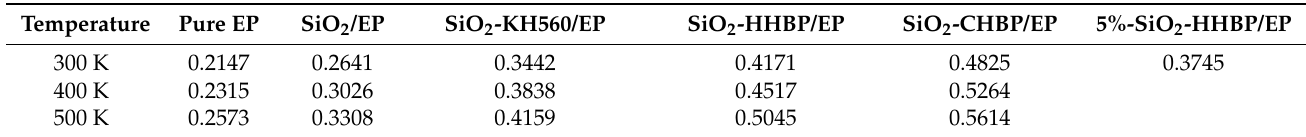
Figure 7. ( a ) Temperature distribution along the heat flux direction, ( b ) heat flux with the change of simulation time, and ( c ) temperature gradient diagram. Table 2. Thermal conductivity of models under different temperatures (units: W/(m ·